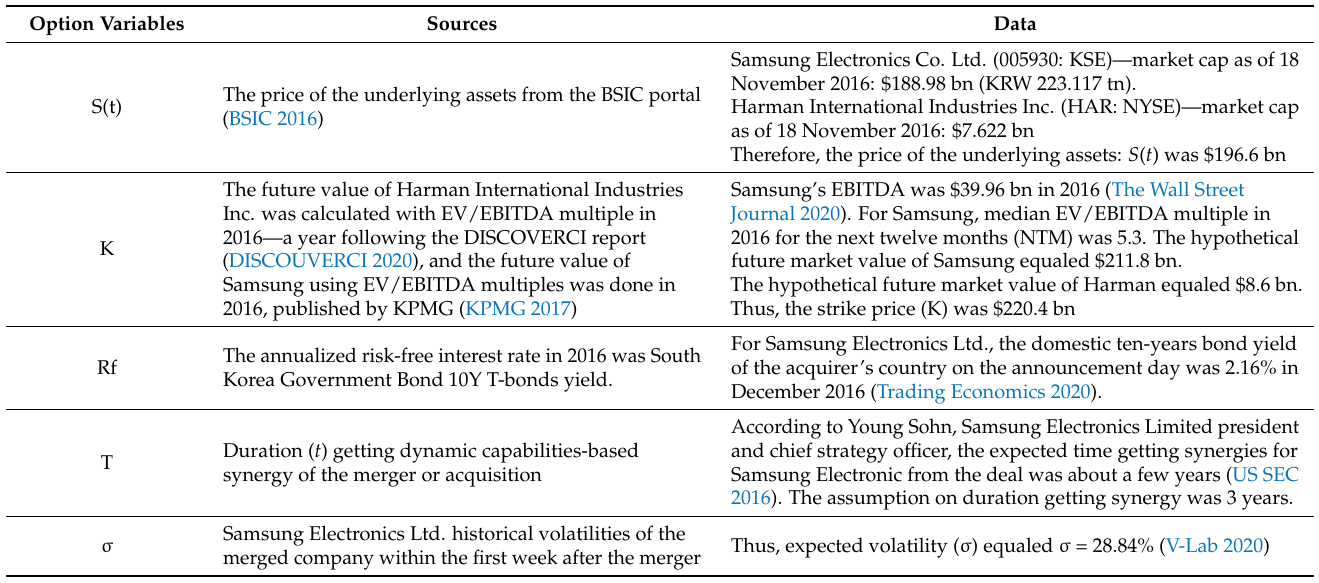
The Black–Scholes option pricing model (Black and Scholes 1973) was used to calculate the theoretical value of options (synergies). Parameters of the Black–Scholes option pricing model to value European call option and thereby to value an M&A deal’s synergy are given Table 2. Black–Scholes option-pricing model variables and their parameters to measure dynamic capabilities-based synergies of Samsung and Harman in an OI type M&A deal. Source: Developed by the author. Option Variables Sources Data